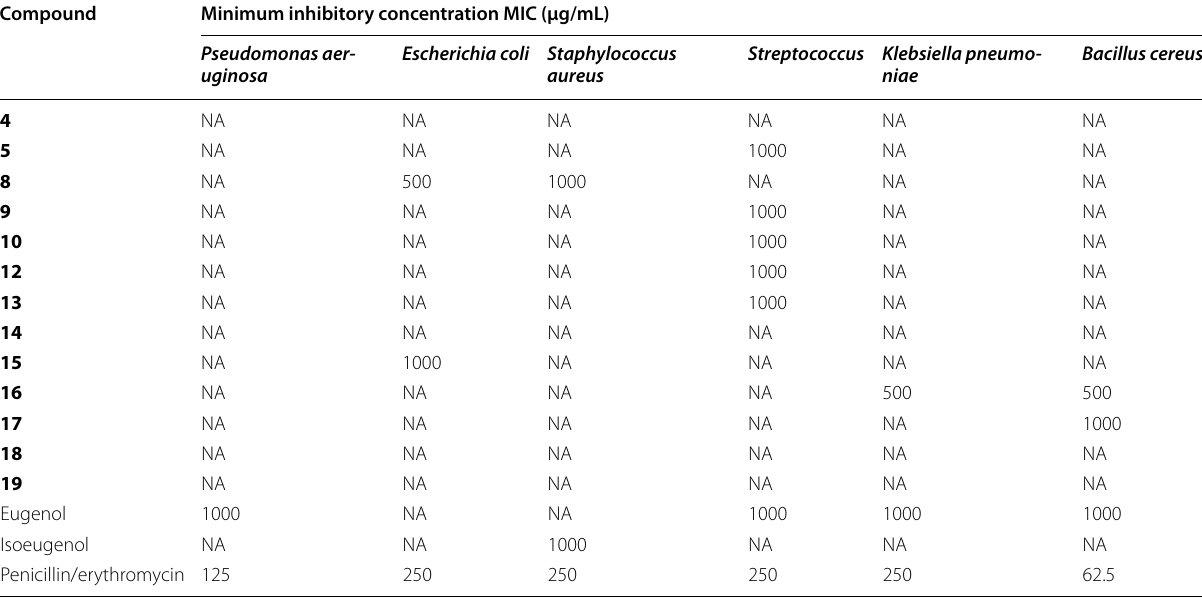
NA no activity at the concentrations analyzed